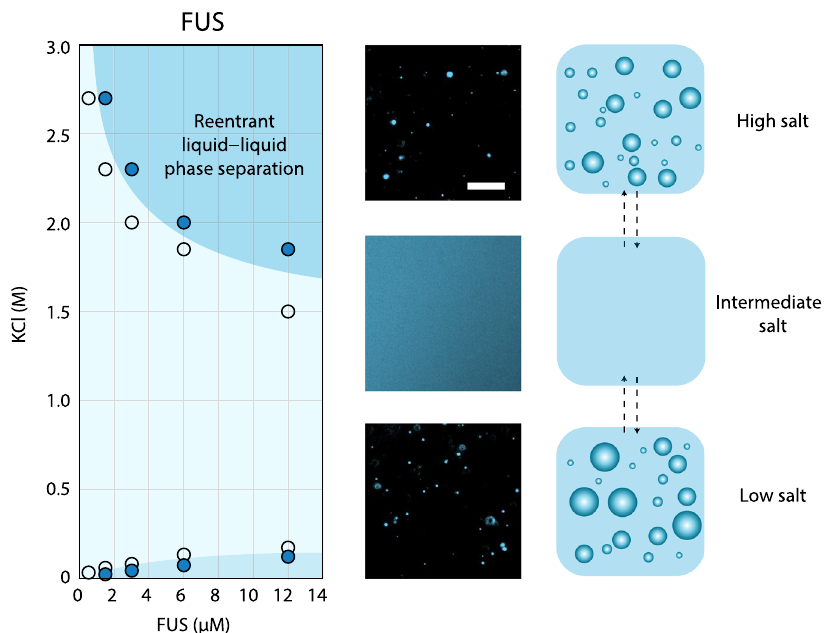
Fig. 1 Reentrant phase separation of FUS at high salt. Phase diagram (left), representative images (center), and schematic (right) of FUS phase separation in the presence of increasing concentrations of KCl. In the phase diagram, markers fi lled with blue indicate concentrations where phase separation was observed in fl uorescence images. Open markers indicate concentrations tested where phase separation did not occur. Darker blue regions are guides for the eyes indicating regions where phase separation of FUS occurs, and light blue is the region where no phase separation occurs. The reentrant phase separation regime is indicated. Fluorescent images of FUS (6 μ M, EGFP labeled) were taken at 50 mM (low salt), 500 mM (intermediate salt), and 2.7 M KCl (high salt) in 50 mM Tris-HCl (pH 7.2). Scale bar is 20 µ m. Each data image (center panel) is representative of the observed behavior from at least three test replicates of the respective protein/salt conditions.